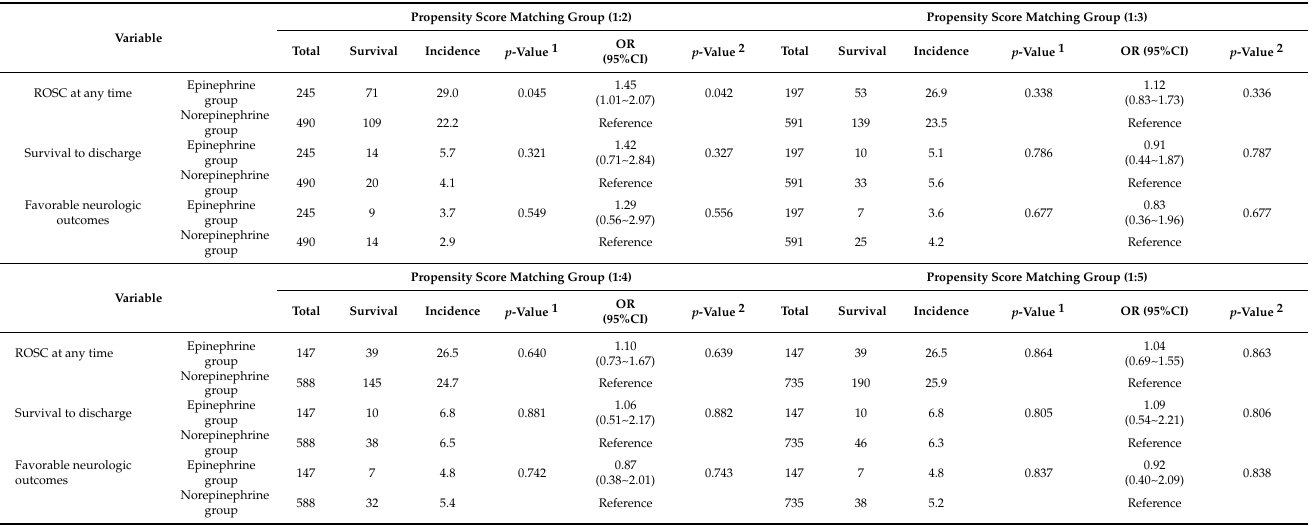
Table A1. The effects of prehospital epinephrine administration by EMS providers during OHCA on survival to discharge and favorable neurological outcomes in 1: N propensity score